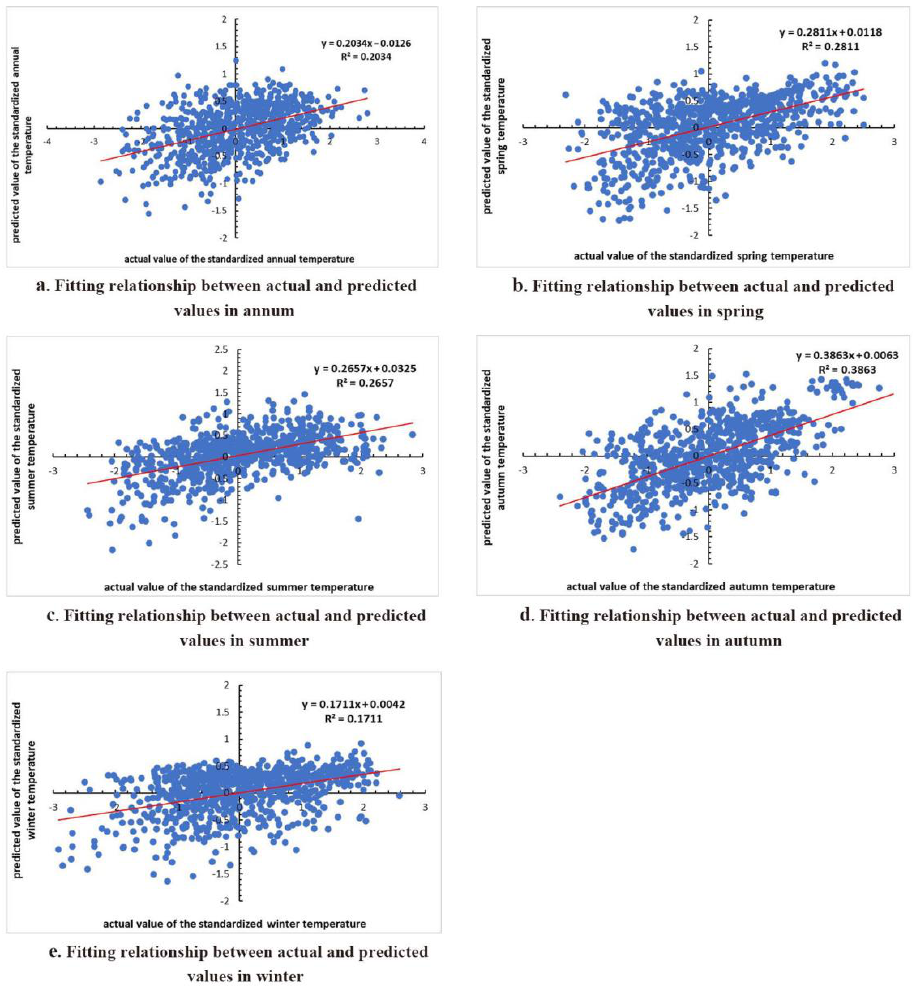
Figure 5. Model between temperature change and its dynamic influencing factors in different periods: ( a ) annum; ( b ) spring; ( c ) summer; ( d ) autumn, and ( e ) winter. As can be seen from Figure 5, the determination coefficient ( 𝑅 2 ) of the model in an- Table 8. T -test for each parameter (spring). num, spring, summer, autumn, and winter are 0.2034, 0.2811, 0.2657, 0.3863, and 0.1711 respectively. The t -tests for each parameter in different periods are shown in Tables 7 – 11. Table 7. T -test for each parameter (annual).